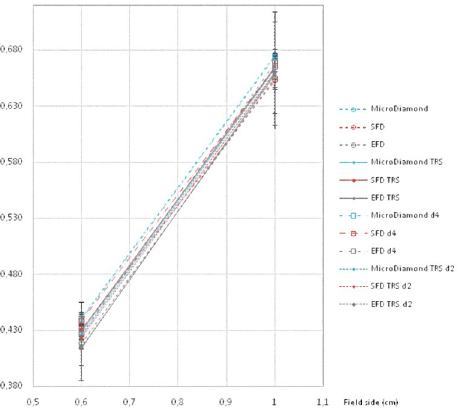
Fig 2. Ratio of detector readings and output factors (OFs) for the 0.6 × 0.6 cm 2 and 1 × 1 cm 2 fields for the 6 MV beams with different detectors, and also with daisy chaining in 4 x 4 cm 2 and 2 x 2 cm 2 .